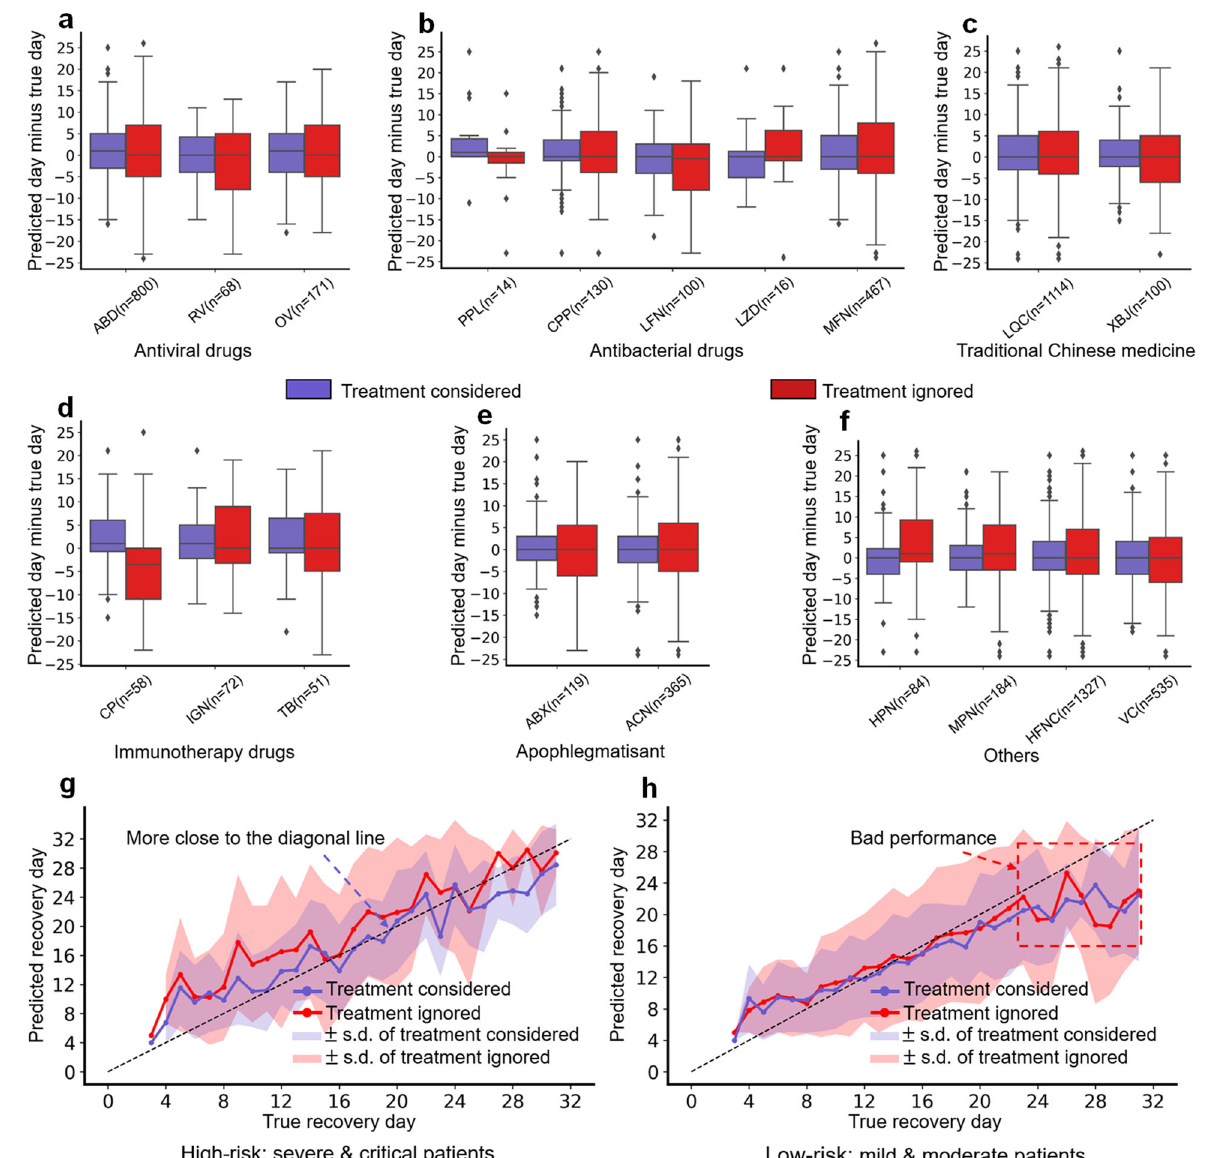
Fig. 4 Distribution and statistics of the day error between the average predicted and true recovery days. a – f Plots of the day error statistics of patients corresponding to each treatment/drug group: antiviral drugs ( ABD arbidol, RV ribavirin, and OV oseltamivir), antibacterial drugs ( PPL piperacillin, CPP cephalosporins, LFN levo fl oxacin, LZD linezolid, and MFN moxi fl oxacin), traditional Chinese medicine ( LQC Lianhua Qingwen Capsule and XBJ Xuebijing), immunotherapy drugs ( CP convalescent plasma, IGN immunoglobulin, and TB tocilizumab), apophlegmatisant ( ABX ambroxol and ACN acetylcysteine), and others ( HPN heparin, MPN Methylprednisolone, HFNC high- fl ow nasal cannula oxygen; and VC Vitamin C). The centerline and the bounds of each box correspond to the median value and the interquartile range, respectively, and the whiskers mark the range of the non-outlier data. g iCOVID can estimate the recovery days of high-risk patients more accurately by considering treatment schemes. h Main prediction error for low-risk patients is derived from the patients who recovered after 24